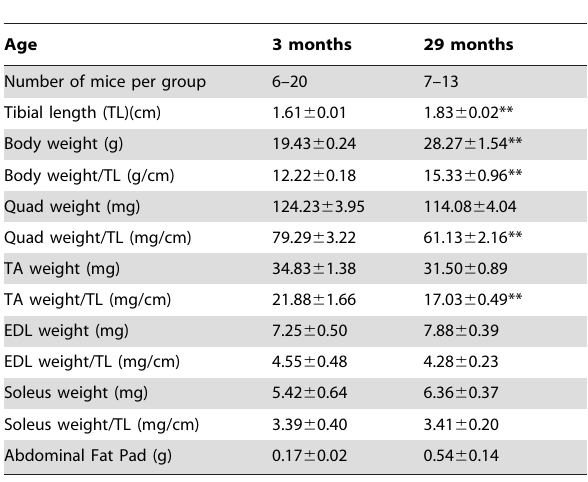
Table 1. Phenotypic characterisation of 3 and 29 month old mice: tibial bone length, body weight, limb muscle weights and abdominal fat pad weight.